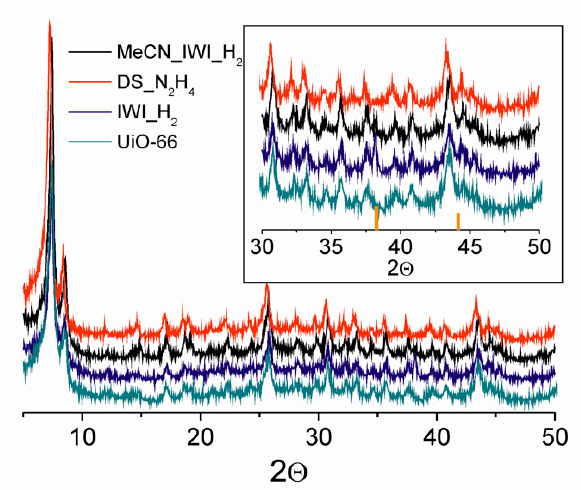
Figure 3. XRD pattern of UiO-66 and Ag@UiO-66 prepared by different methods. Orange bars correspond to reflexes of (111) and (200) crystal planes of zero-valent Ag FCC crystal.